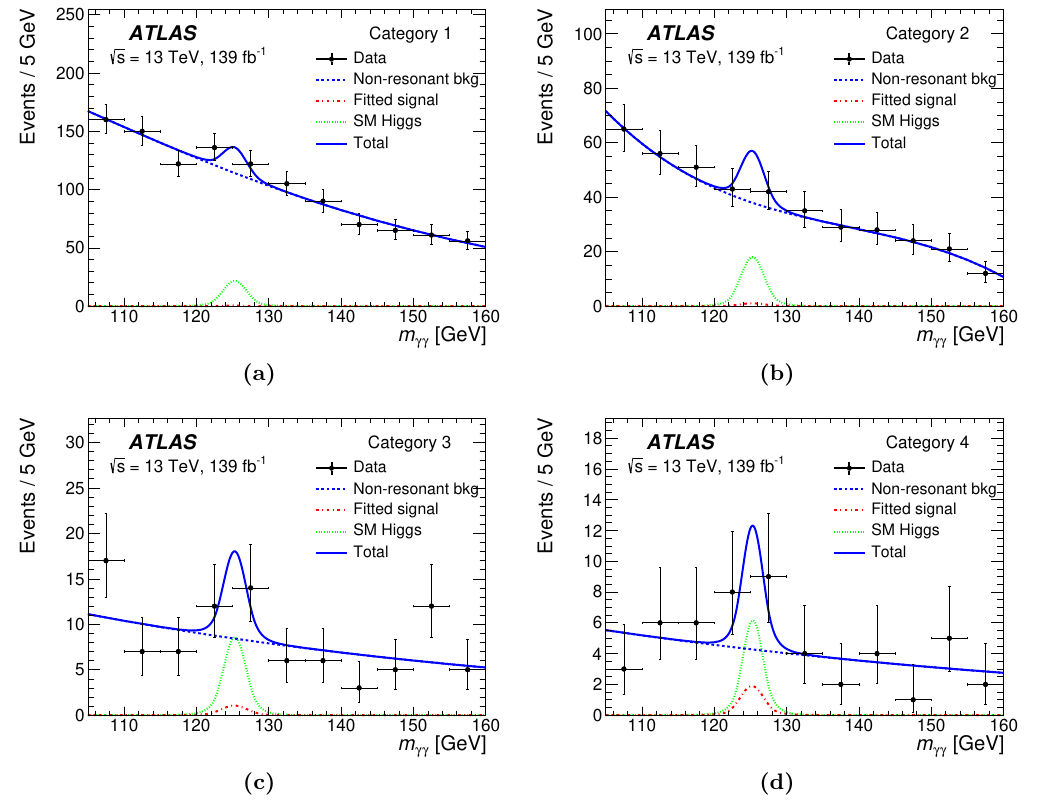
Figure 4 . Diphoton invariant mass spectra and the corresponding (cid:12)tted signal and background in the Leptonic categories (a) 1, (b) 2, (c) 3, and (d) 4. The signal samples shown correspond to ! W (cid:6) ~ (cid:31) 0 the ~ (cid:31) (cid:6) ~ (cid:31) 0 h ~ (cid:31) 0 signal with m (~ (cid:31) (cid:6) = ~ (cid:31) 0 ) = 200 GeV and m (~ (cid:31) 0 ) = 0 : 5 GeV. The non-resonant 1 2 1 1 1 2 1 background (dashed curve), the SM Higgs boson (dotted curve), and the signal (dash-dotted curve) are obtained from a simultaneous signal-plus-background (cid:12)t to the full m (cid:13)(cid:13) spectrum for the 12 categories. The total of these contributions is shown by the solid